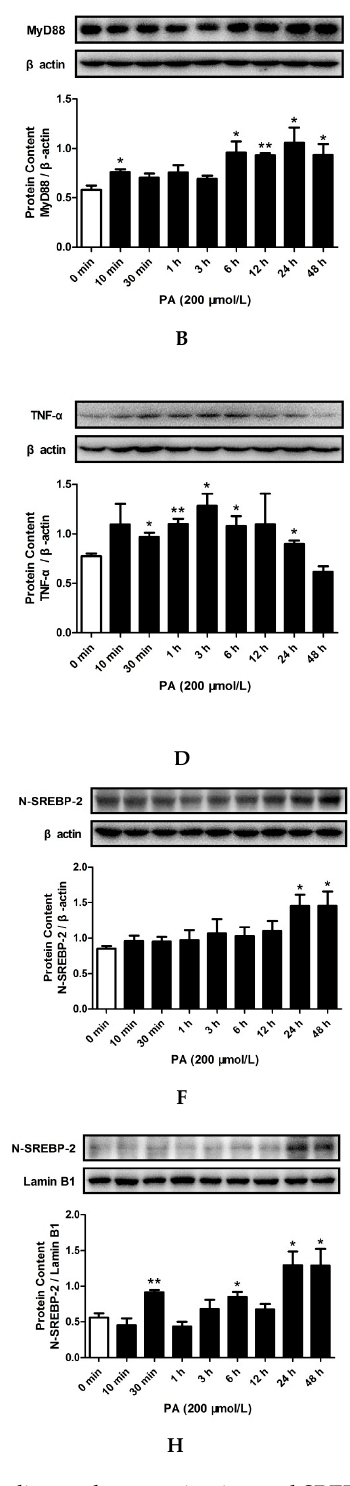
Figure 4. Effects of PA on TLR4/MyD88/NF- κ B signaling pathway activation and SREBP-2 expression in HepG2 cells. Cells were treated with PA (200 μ mol/L) for 0 min, 10 min, 30 min, 1 h, 3 h, 6 h, 12 h, 24 h, or 48 h. The total protein levels of TLR4 ( A ), MyD88 ( B ), TNF- α ( D ), pre-SREBP-2 ( E ), N-SREBP-2 ( F ), and p65 phosphorylation ( C ) were measured by Western blotting. The nuclear protein levels of p65 ( G ) and N-SREBP-2 ( H ) were detected by Western blotting. The results are presented as means ± SD of three independent experiments; *: p < 0.05 vs. 0 min; **: p < 0.01 vs. 0 min. 2.4. Inhibition of MyD88 Reduced Cholesterol Content in LPS- and PA-Treated HepG2 Cells MyD88 is an upstream molecule of the TLR4/MyD88/NF- κ B signaling pathway that triggers the inflammation induced by LPS or PA [12,27,28]. It is known that inflammation increases the cholesterol accumulation in hepatic cells. To investigate the effect of MyD88 on cholesterol accumulation, HepG2 cells were pre-incubated with 20 μ mol/L of ST2825 for 2 h and stimulated with LPS for 12 h or with PA for 24 h, and the intracellular cholesterol content was determined. Filipin was used to determine the free cholesterol in HepG2 cells [29]. As shown in Figure 5, ST2825-only treatment for 16 h and 26 h did not alter the levels of TC and free cholesterol in the HepG2 cells. LPS or PA treatment significantly increased the levels of TC and free cholesterol. This is in agreement with the results of time-dependent experiments. Compared with the LPS and PA groups, ST2825 pre-incubation significantly decreased the levels of TC and free cholesterol. A